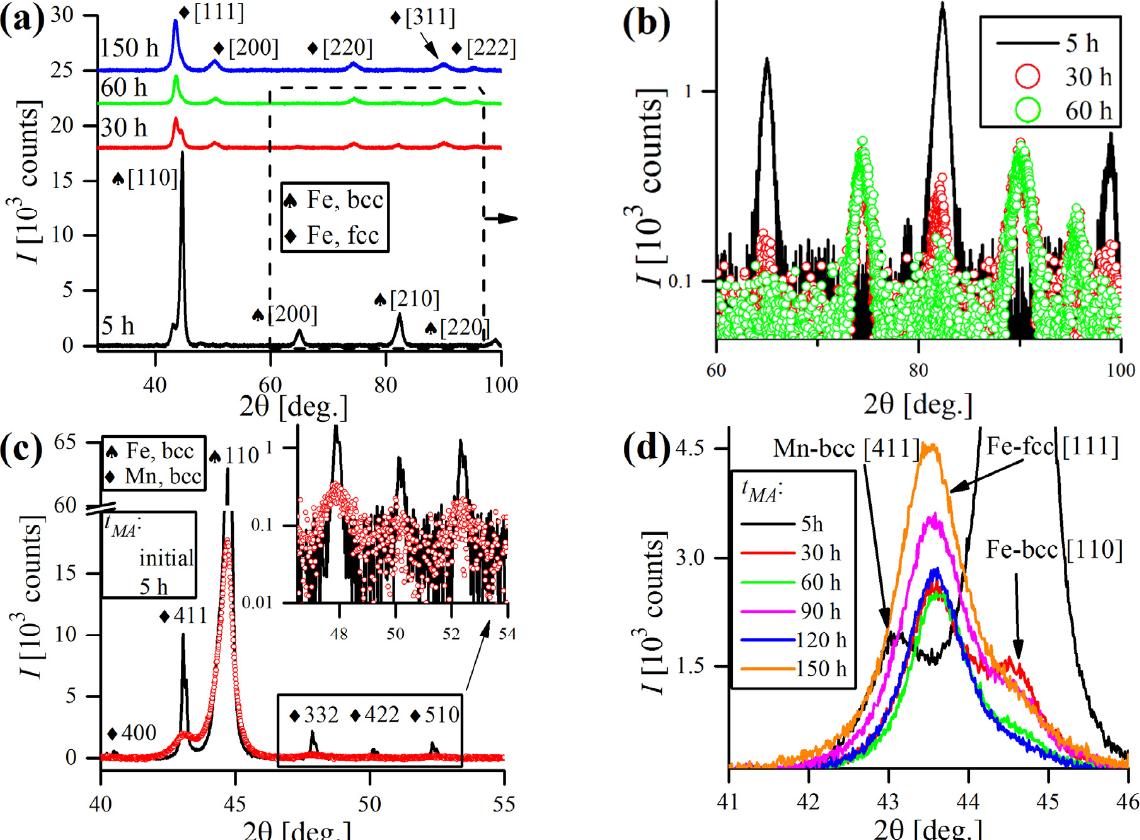
Figure 5. Microstructural evolution of Fe-18Cr-18Mn alloy: ( a ) overall comparison of XRD patterns after a certain MA time, ( b ) insight showing the vanishing of Fe-bcc peaks, ( c ) comparison of initial and after 5 h of MA patterns with emphasis on Mn-bcc reflections, ( d ) changes of the shape and intensity of most prominent Fe-bcc [110] and Fe-fcc [111] reflections during the MA course. XRD patterns were fitted using the pseudo-Voigt function and the extracted data (peak 2 θ position and FWHM) were processed in accordance with the MWH procedure, using the calculated contrast factor values for Fe-bcc and Fe-fcc phases, and regarding the instrumental broadening correction and proper background definition. The phase percentage was estimated by the ratio of integrated areas of peak profiles of Fe-bcc and Fe-fcc phases, respectively, as presented in Figure